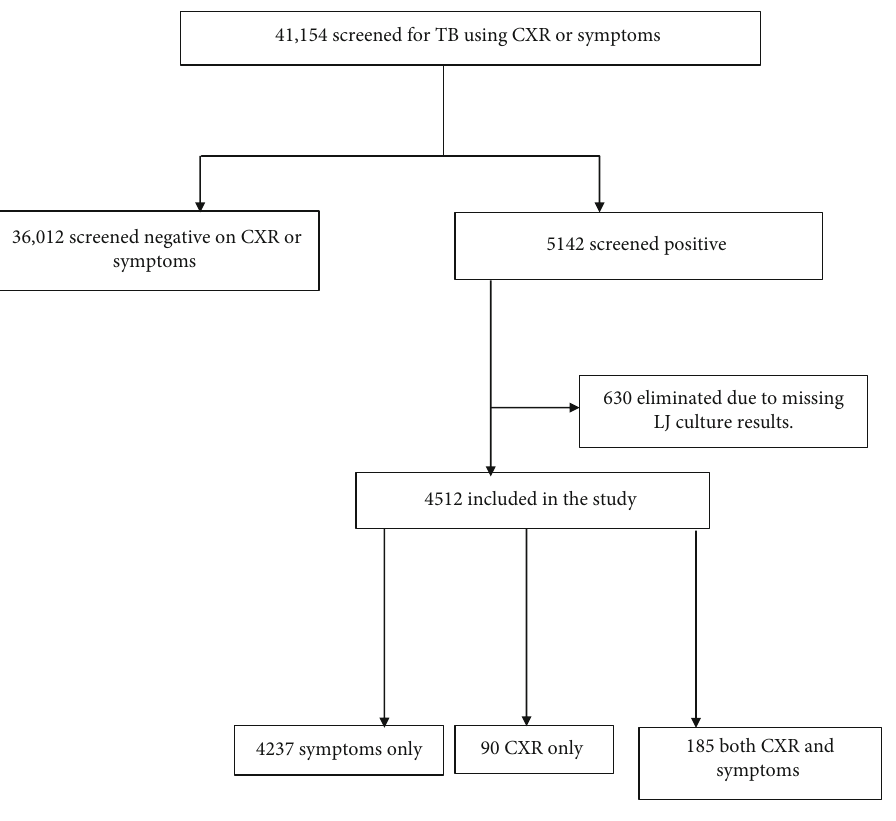
Figure 1: Study pro fi